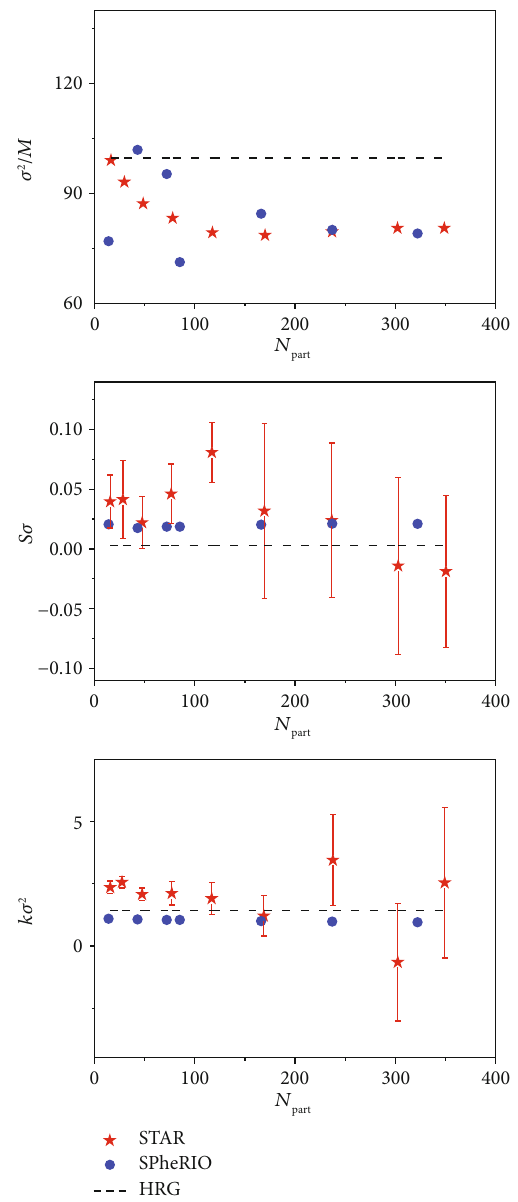
Figure 2: (Color online.) The centrality dependence of the calculated higher moments of multiplicity of net charge. The results are for Au+Au collisions at 200GeV. The STAR data are from Ref. [27], presented by fi lled red stars. The SPheRIO results are shown in the fi lled blue circle, and the dashed black line gives that from the HRG calculations process. To be speci fi c, we further investigate the e ff ect of the IC, as well as the temporal expansion of the system. The hydrodynamical model employed in the study does not contain any additional free parameters, as the existing ones have been determined in reproducing the particle spectra in previous